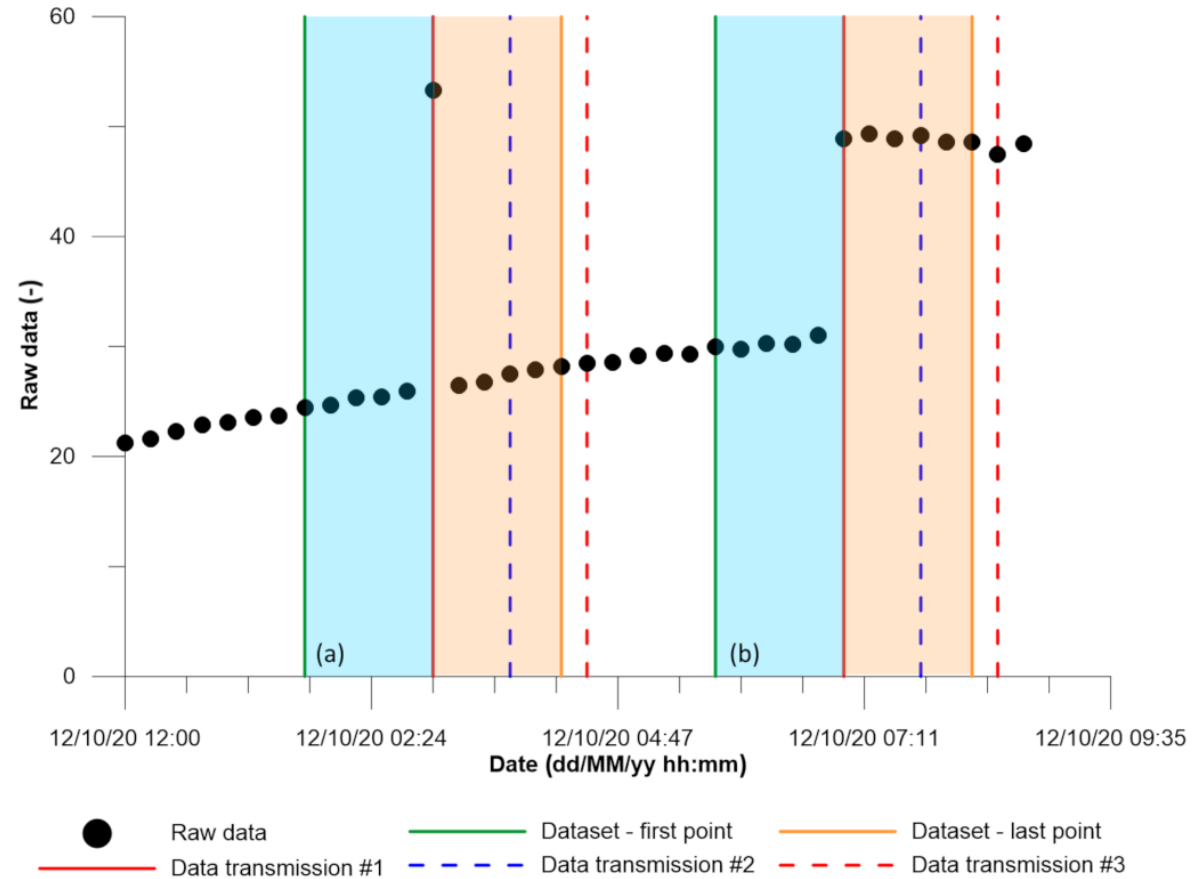
Figure 4. Raw data analysis, focusing on a spike event ( a ) and an actual displacement ( b ), was performed by using an 11-element data window centered on the continuous red line points, ranging between the green line and the orange line. Data transmissions are represented by red, dashed blue and dashed red lines